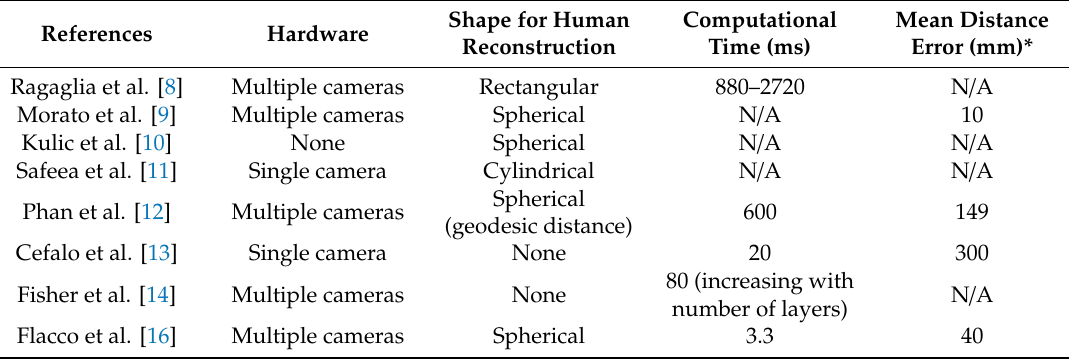
Table 1. Comparative analysis of the SoA methodologies for human–robot collaboration (HRC) using external vision